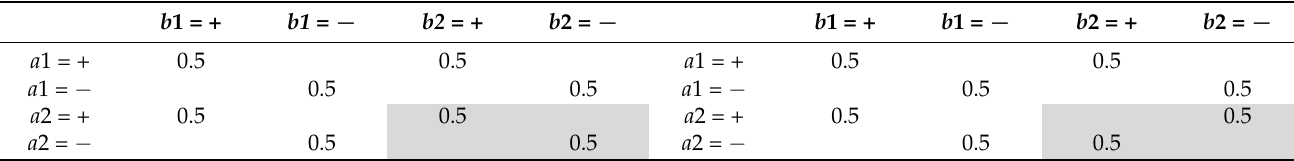
NB. Each table is four separate probability subtables, corresponding to different measurements for the two systems. For the left table, S = 2, and for the right, S = 4 > 2. It can be shown that the right table is inconsistent (Appendix A). The right table is a famous one, corresponding to the Popescu-Rohlich box (PR-box;